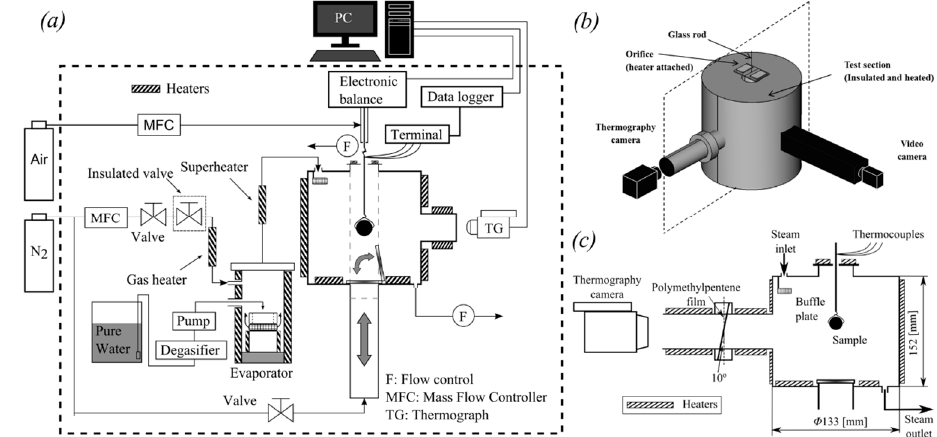
Figure 4. ( a ) The configuration of the experimental setup; ( b ) measurement of the surface temperature by thermography camera and the observation of the sample surface by a video camera; and ( c ) the geometrical specification of the measurement of the surface temperature of a coal sample [18].